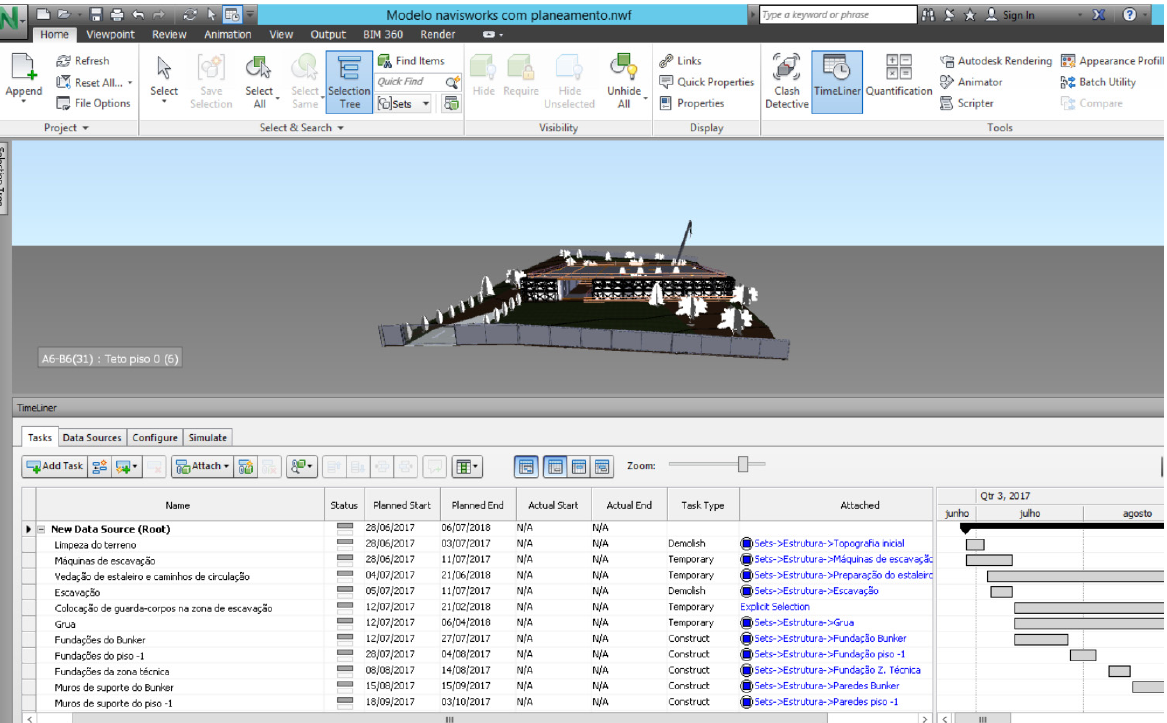
Figure 7. Construction building planning.